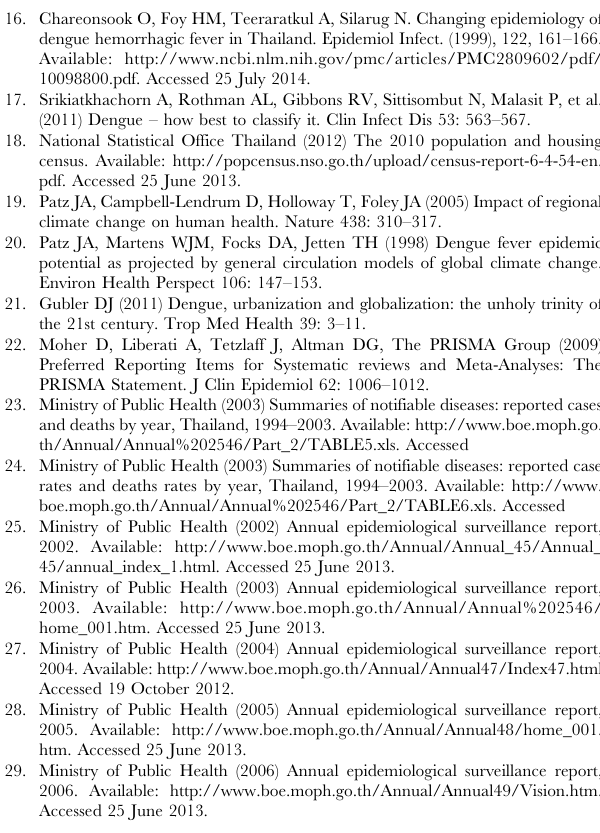
Figure S1 Regions of Thailand used by the Thai Ministry of Public Health (MoPH). Table S1 Databases searched for citations relating to dengue disease epidemiology in Thailand. Table S2 Evidence table for citations fulfilling the inclusion and exclusion criteria for the literature review (n= 40).